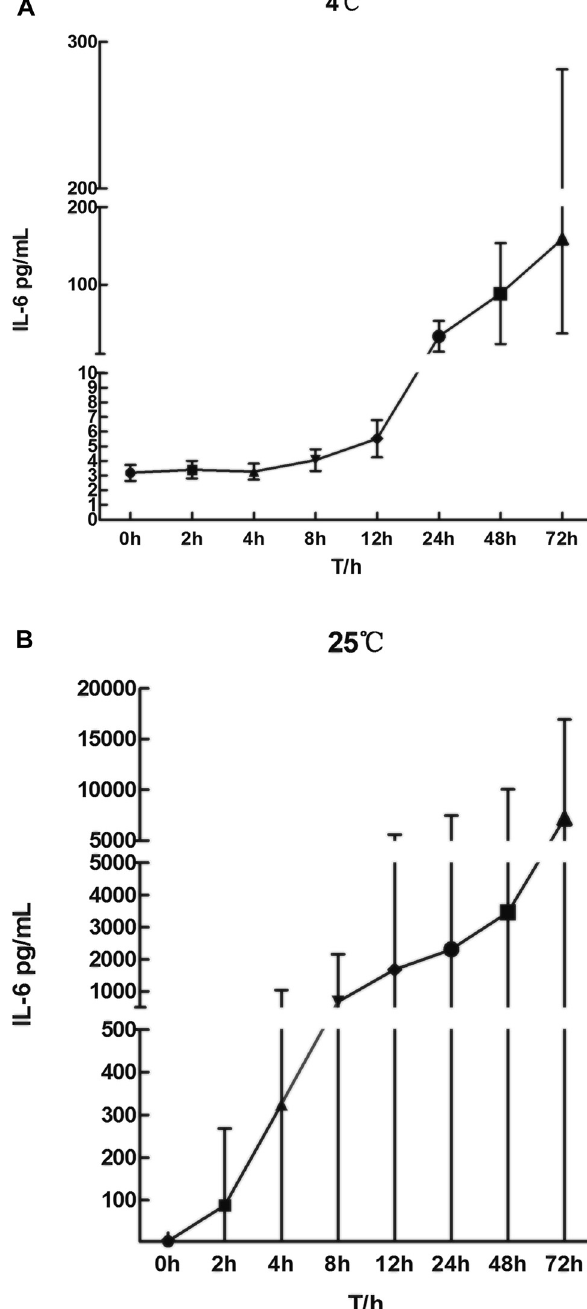
Figure 3: Concentrations of IL-6 in patients with breast neoplasms stored at 4 ° C (A) and 25 ° C (B) at different